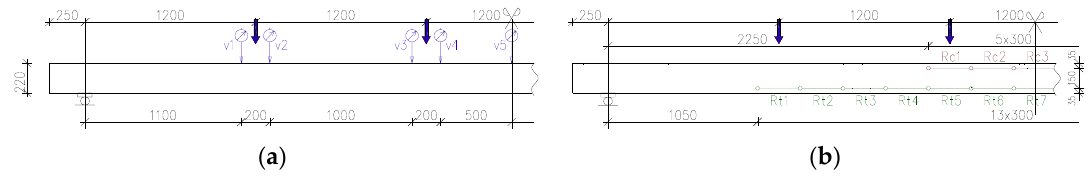
Figure 4. Strain gauges on CFRP strips ( A —Bottom and lateral side; B —Lateral side).